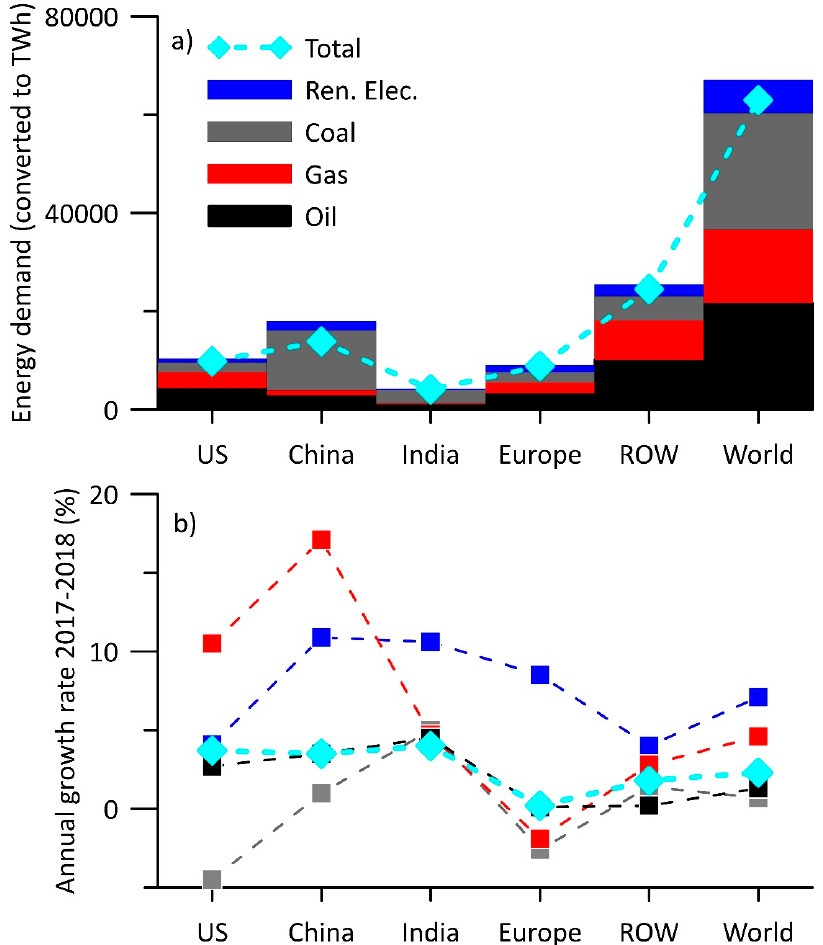
Figure 1. Energy demand and annual energy demand growth from selected sources [7]. To enable comparison across different fuel types they were also converted to electricity in TWh (NB. Not calorific equivalents). ( a ) Energy demand (2018) by country/area where ROW = Rest of World. ( b ) Annual growth 2017–2018 (in %). Conversion factors; 1 Mtoe produces approx. 4.4 TWh electricity; 1 barrel of oil per day = 49.8 tonnes per year; 1 bcm gas = 0.86 Mtoe; 1.5 tonnes of hard coal or 3 tonnes lignite and sub-bituminous coal (average 2.25 tonnes = 1 tonne oil)